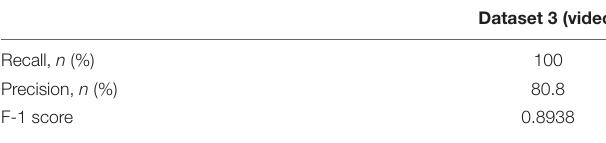
TABLE 5 | Test results of the DeFrame